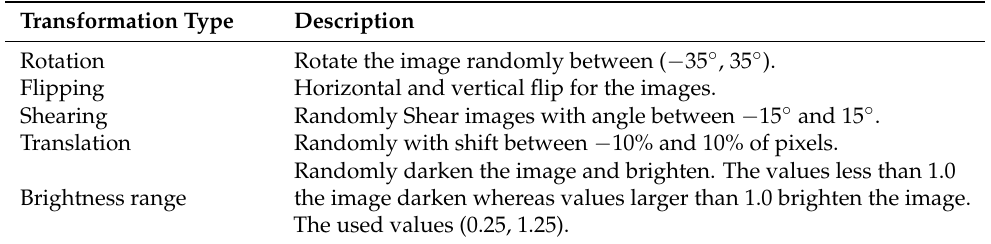
Table 5. Data augmentation parameters.